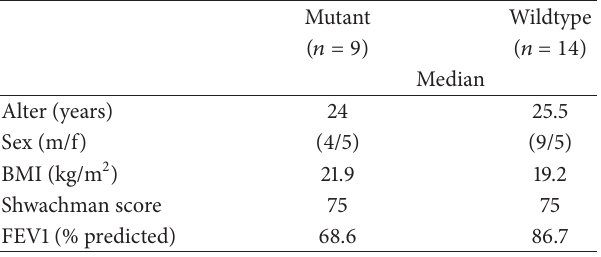
Table 4: TGF 𝛽 1 variant − 509C/T. Patients characteristics.